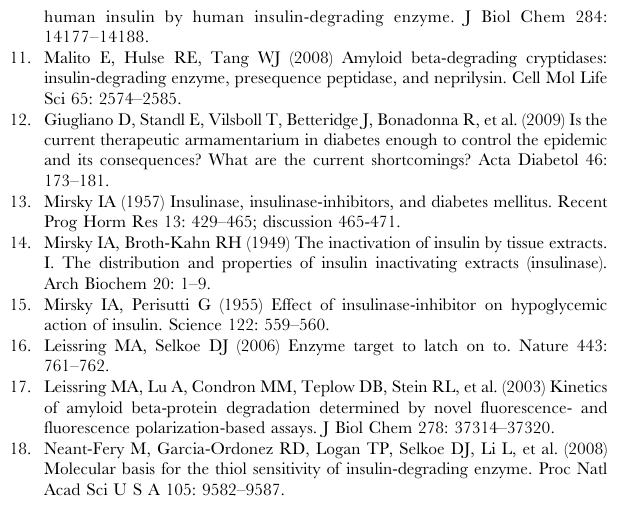
General Procedure for the Hydrolysis of Methyl Esters 21 and 23 to acids (R)-7a and (S)-7b A solution of the methyl ester